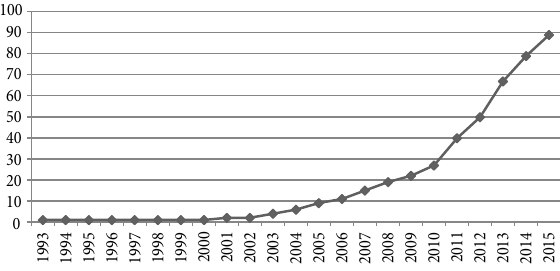
Fig. 2. Distribution papers based on year of